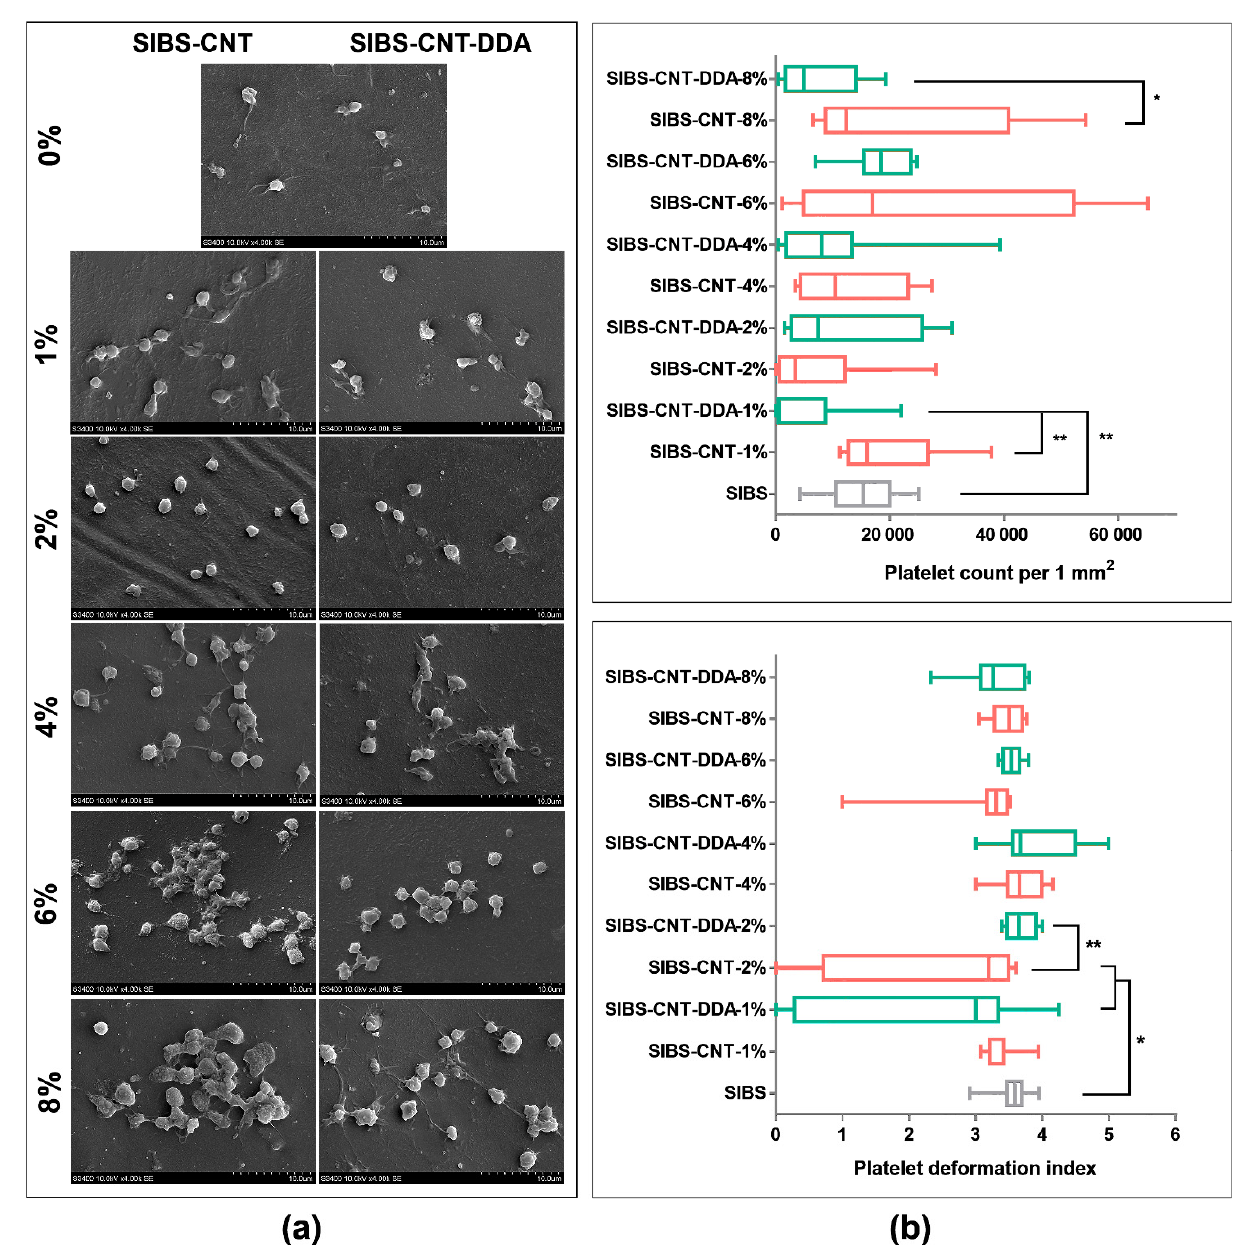
Figure 9. Platelet-surface adhesion of the studied nanocomposites. SEM images of platelet adhesion on the surfaces of nanocomposites ( a ). The platelet count and platelet deformation index of nanocomposite films ( b ). One asterisk (*) signifies a p value equal to or smaller than 0.05 ( p ≤ 0.05); Two asterisks (**) signify a p value equal to or smaller than 0.01 ( p ≤ 0.01). Types III and IV platelets were the most predominant on the surface of SIBS, while type V platelets and type II platelets were found less frequently. Incorporating 1 wt% CNTs into SIBS did not affect the platelet adhesion. Increasing CNTs concentration to 2 wt% led to a slight decrease in the platelet count ( p < 0.05) and in the platelet deformation index ( p <